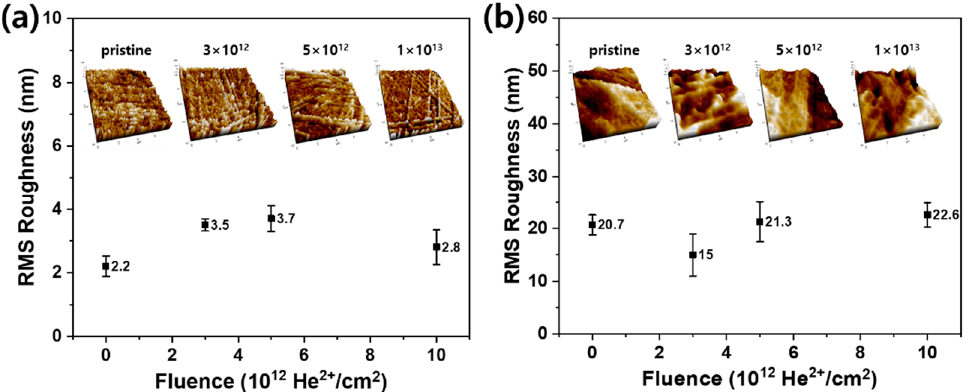
Figure 4. RMS roughness and corresponding AFM images of ( a ) PS and ( b ) HDPE surfaces irradiated at various fluences.